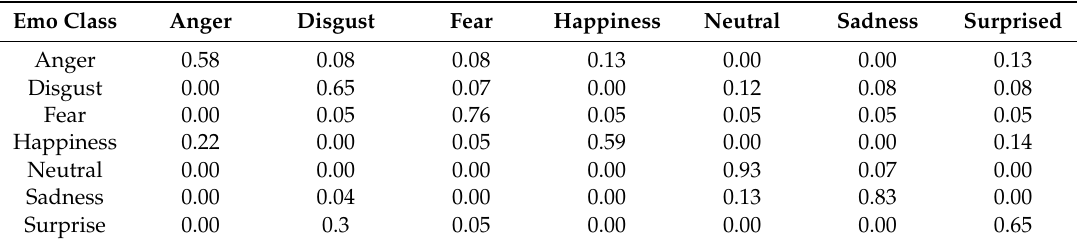
Table 9. Confusion matrix for emotion prediction on SAVEE using RAVDESS and